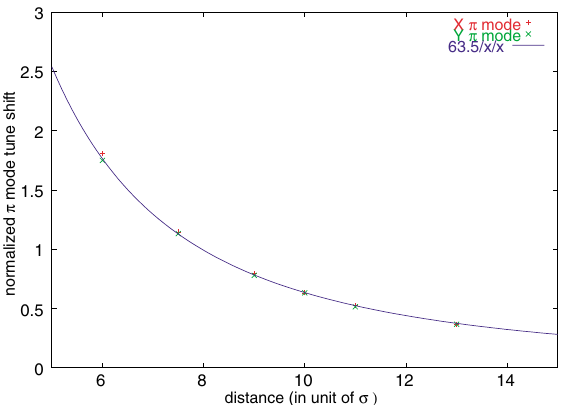
FIG. 8. (Color) The rms emittance as a function of turns during the sweeping process.